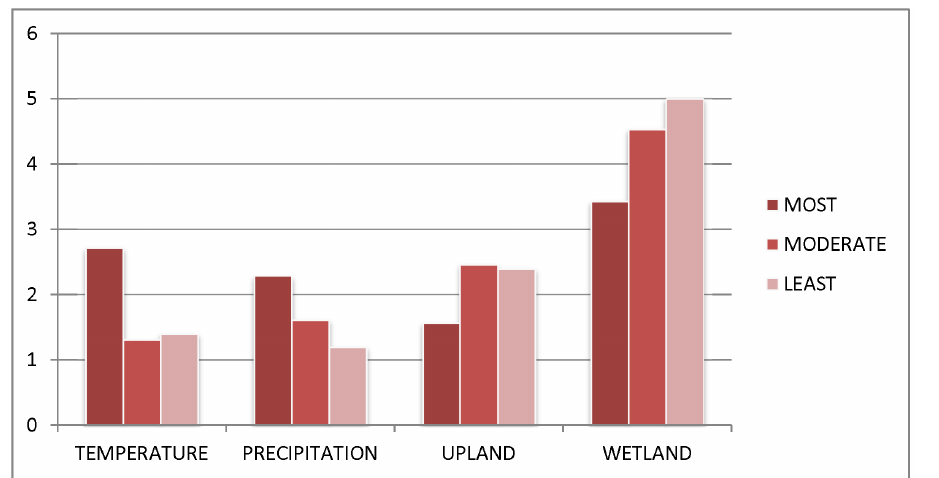
Figure 5. The frequency (y-axis) of variable type (x-axis) in top ten variables for waterbird species distribution models, grouped by species sensitivity to climate change. The most sensitive species were projected to lose $ 66% of their current habitat; moderately sensitive species 33–65%; and least sensitive , 33%.